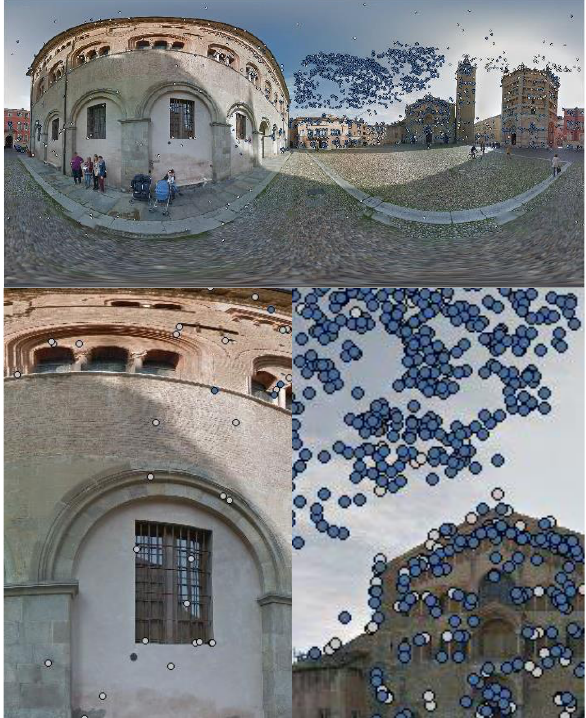
Figure 5. Example of typical matched point in an outdoor spherical